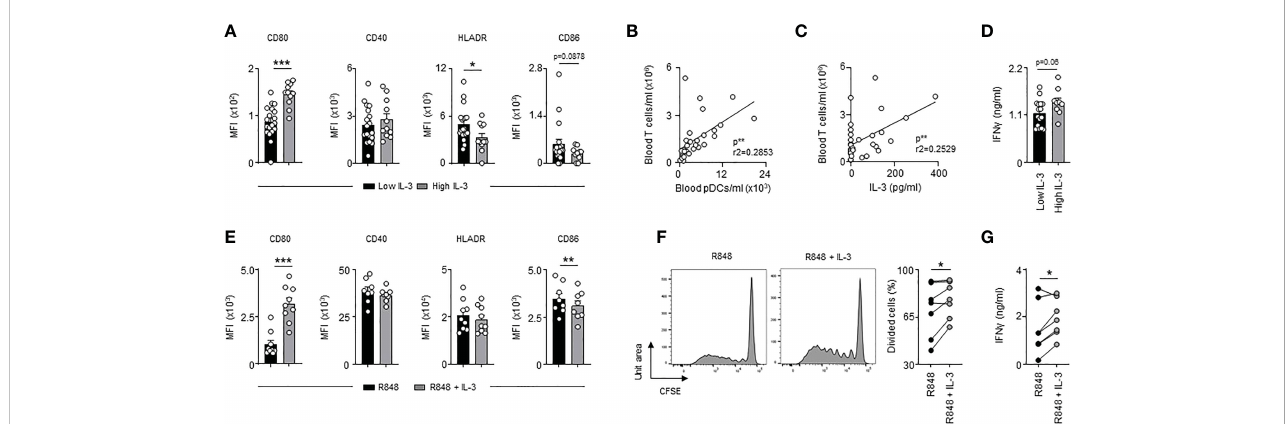
FIGURE 5 High plasma IL-3 levels in SARS-CoV-2 infections are associated with increased T cell activation. (A) Cumulative mean fl uorescence intensity of CD80, CD40, HLADR and CD86 expressed at the surface of circulating pDCs from SARS-CoV-2 + patients with low or high plasma IL-3 levels (n=30). (B) Correlation between the concentration of blood T cells and blood pDCs in SARS-CoV-2 + patients (n=30). Data were analysed by Pearson correlation test. (C) Correlation between blood T cells concentration and plasma IL-3 levels in SARS-CoV-2 + patients (n=30). Data were analysed by Pearson correlation test. (D) Levels of plasma IFN g in SARS-CoV-2 + patients with low or high plasma IL-3 levels (n=30). (E) Cumulative mean fl uorescence intensity of CD80, CD40, HLADR and CD86 expressed at the surface of circulating pDCs 24h after R848 stimulation in the presence or the absence of IL-3 (n=8-9). (F, G) Allogenic T cells were cocultured during 6 days with R848-activated pDCs pre-treated or not with IL-3. (F) Representative histogram and percentage of proliferating allogenic T cells (n=7). (G) Levels of IFN g in culture supernatant 24h after R848 stimulation in the presence or the absence of IL-3 (n=7). Data are mean ± s.e.m., *P < 0.05, **P < 0.01, ***P < 0.001, paired 2-tailed Student ’ s t test or unpaired 2-tailed Student ’ s t test using Welch ’ s correction for unequal variances were